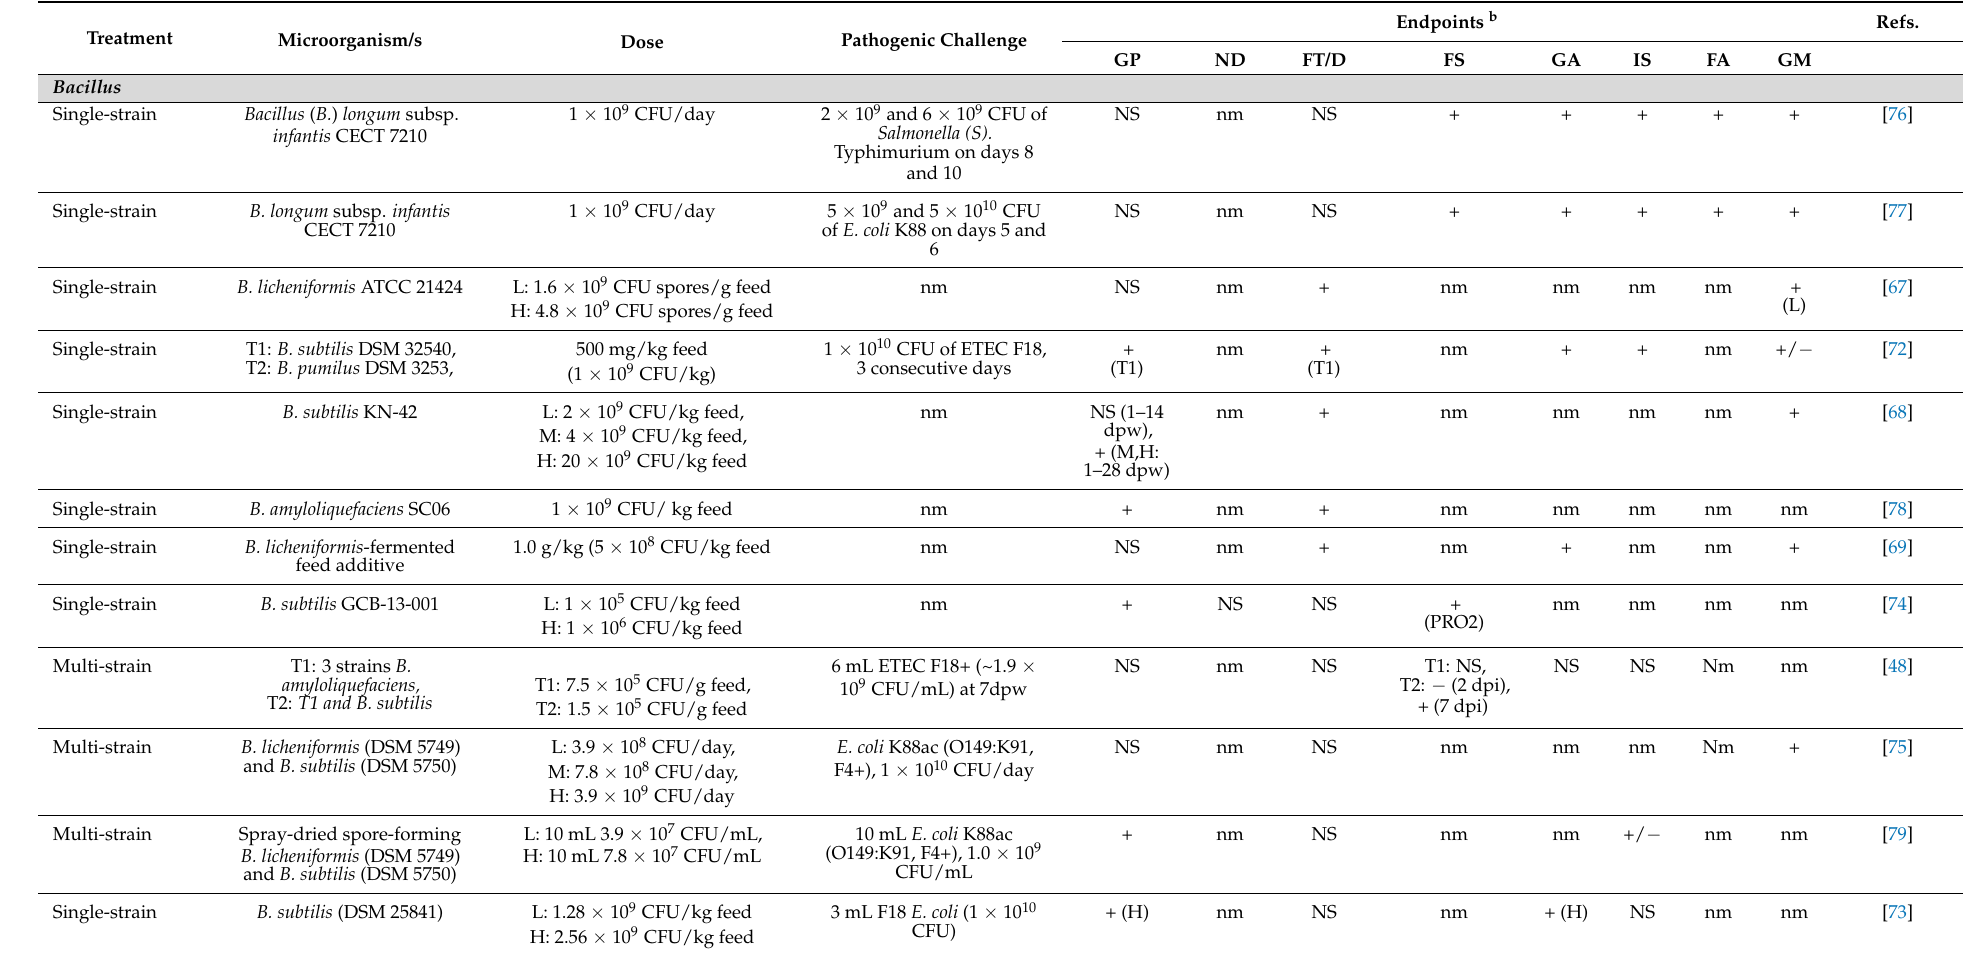
Table 2. Effects a of probiotics on various parameters in